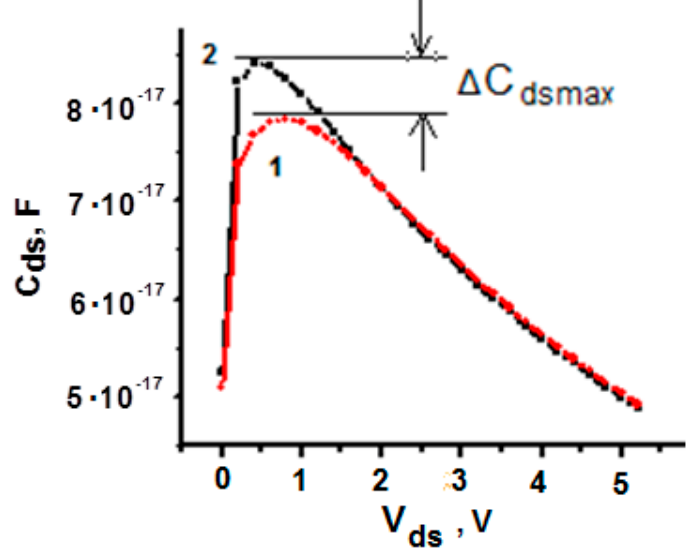
Figure 3. C–V dependences of drain–substrate junction without embedded charge ( 1 ) and at embedding the local oxide charge near the drain ( 2